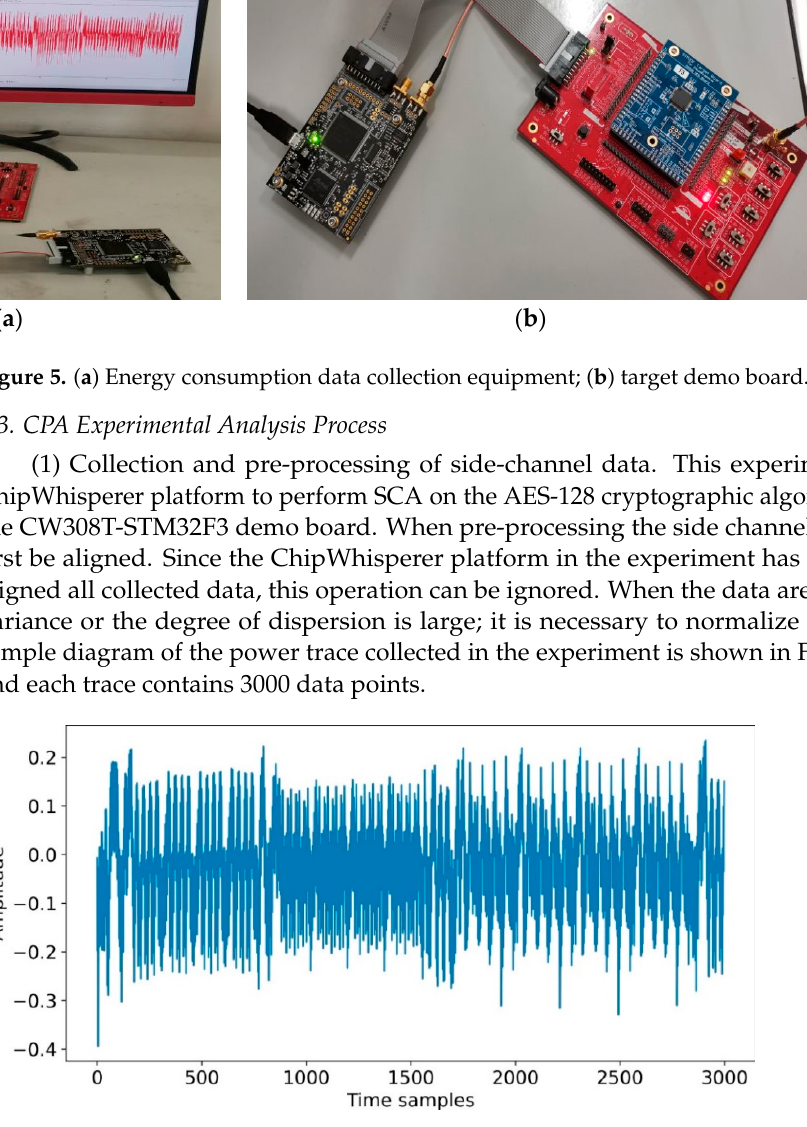
Figure 6. Single power trace